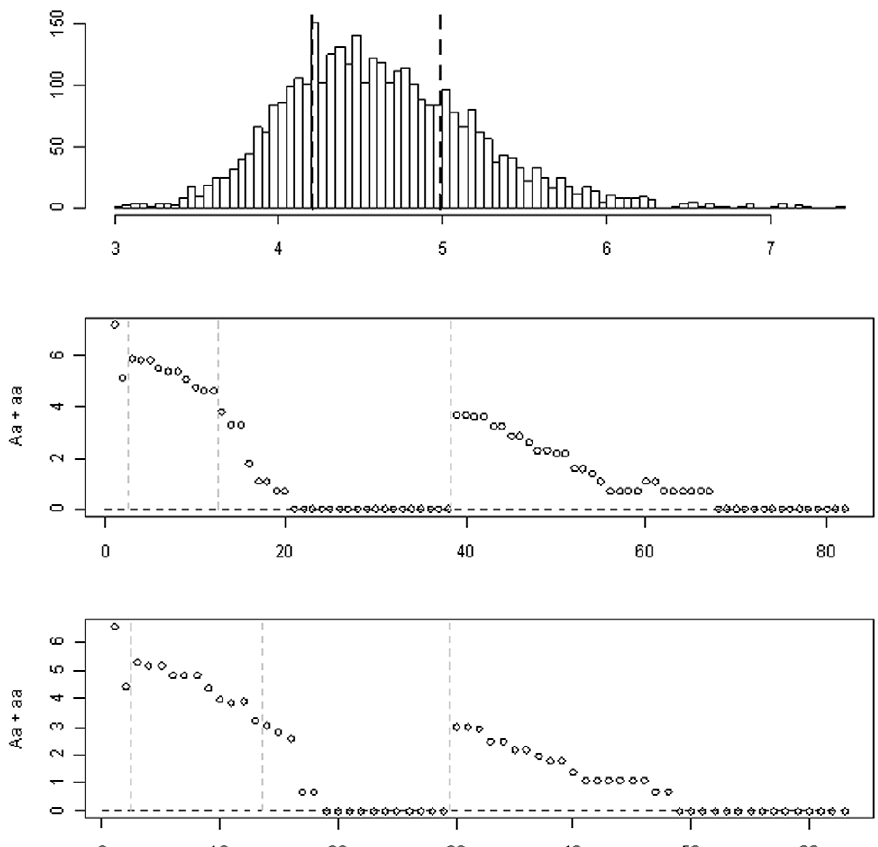
Figure 1. The Dallas Heart Study data set. The top panel: the histogram of the log-transformed plasma levels of triglyceride and the 25th and 75th percentiles (the black dotted lines). The middle panel: the logarithm of the observed count of heterozygotes (Aa) and rare homozygotes (aa) for each variant in the continuous trait analysis. The bottom panel: the logarithm of the observed count of Aa and aa for each variant in the binary trait analysis. The gray dotted lines show the four groups: common non-synonymous, common synonymous, rare non-synonymous, and rare synonymous.